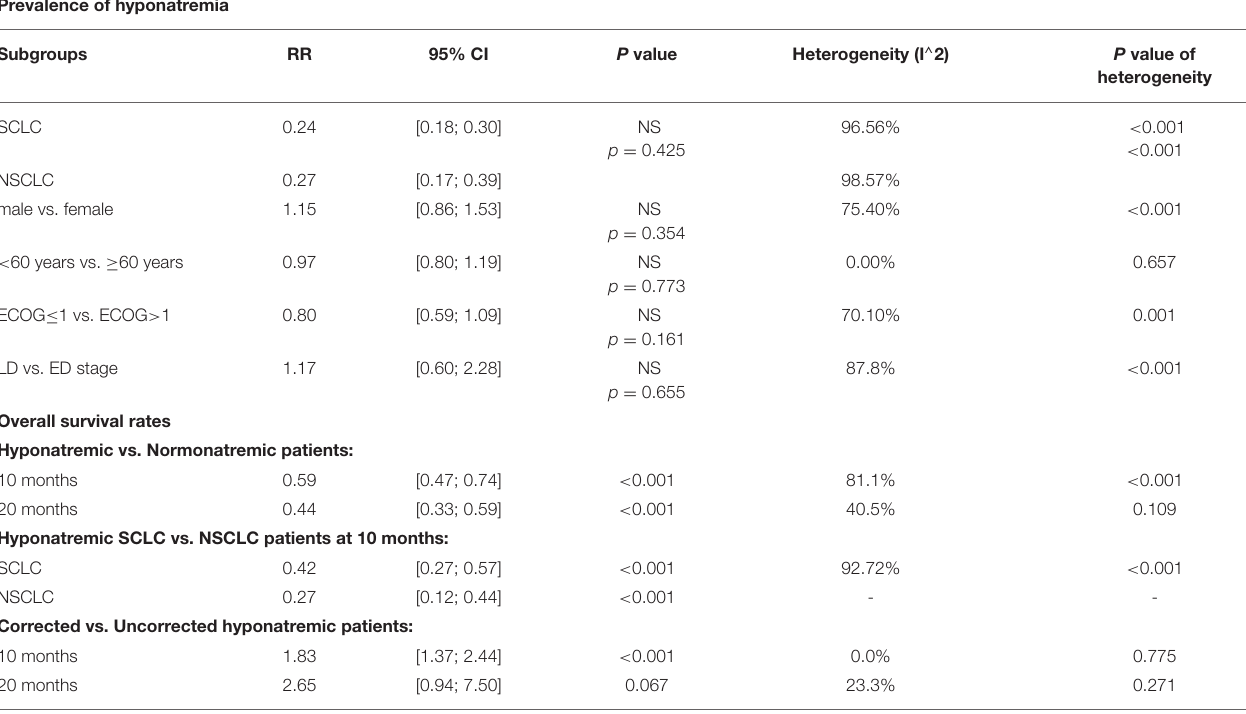
TABLE 5 | Results of the statistical analyses. Prevalence of